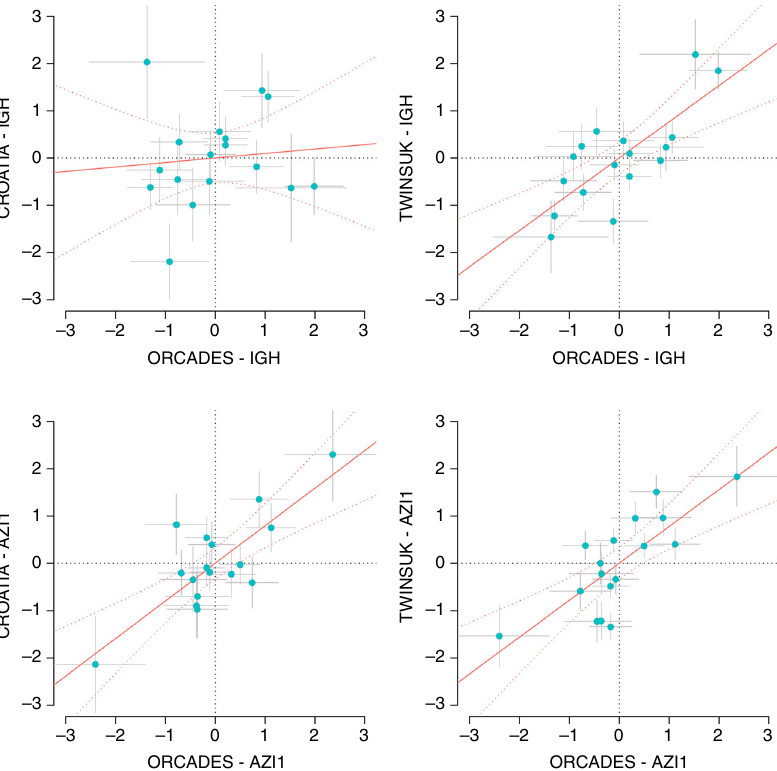
Fig. 2 Comparison of the estimated genotype – phenotype partial correlations between discovery and replication cohorts. The IGH and AZI1 loci for the 17 traits in the IgG galactosylation group are displayed. The partial correlations were standardized to z -scores so that the regression slope and con fi dence intervals ( red curves ) represent the amount of correlation in the effect sizes between each named cohort. The gray bars represent standard